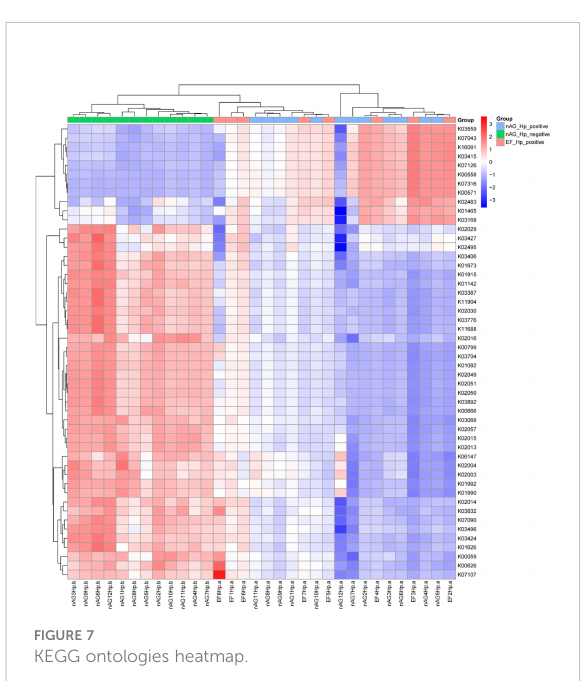
FIGURE 7 KEGG ontologies heatmap.